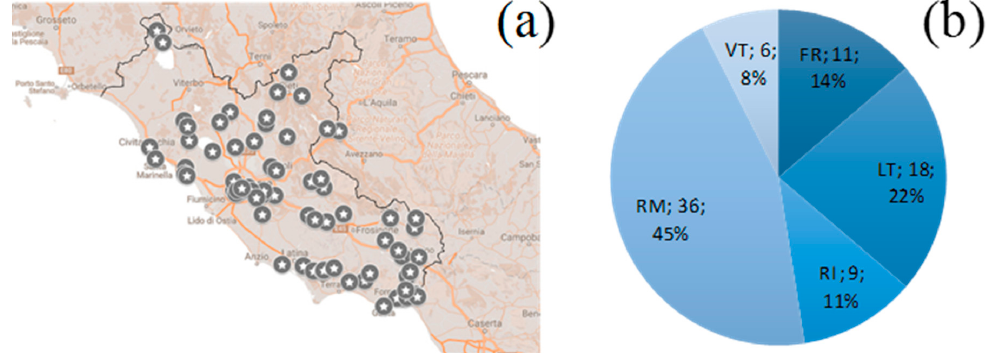
Figure 2. Spatial distribution of the analyzed schools in the Lazio territory: ( a ) map and ( b ) number of schools per province (RM = Rome; VT = Viterbo; FR = Frosinone; LT = Latina; RI = Rieti).